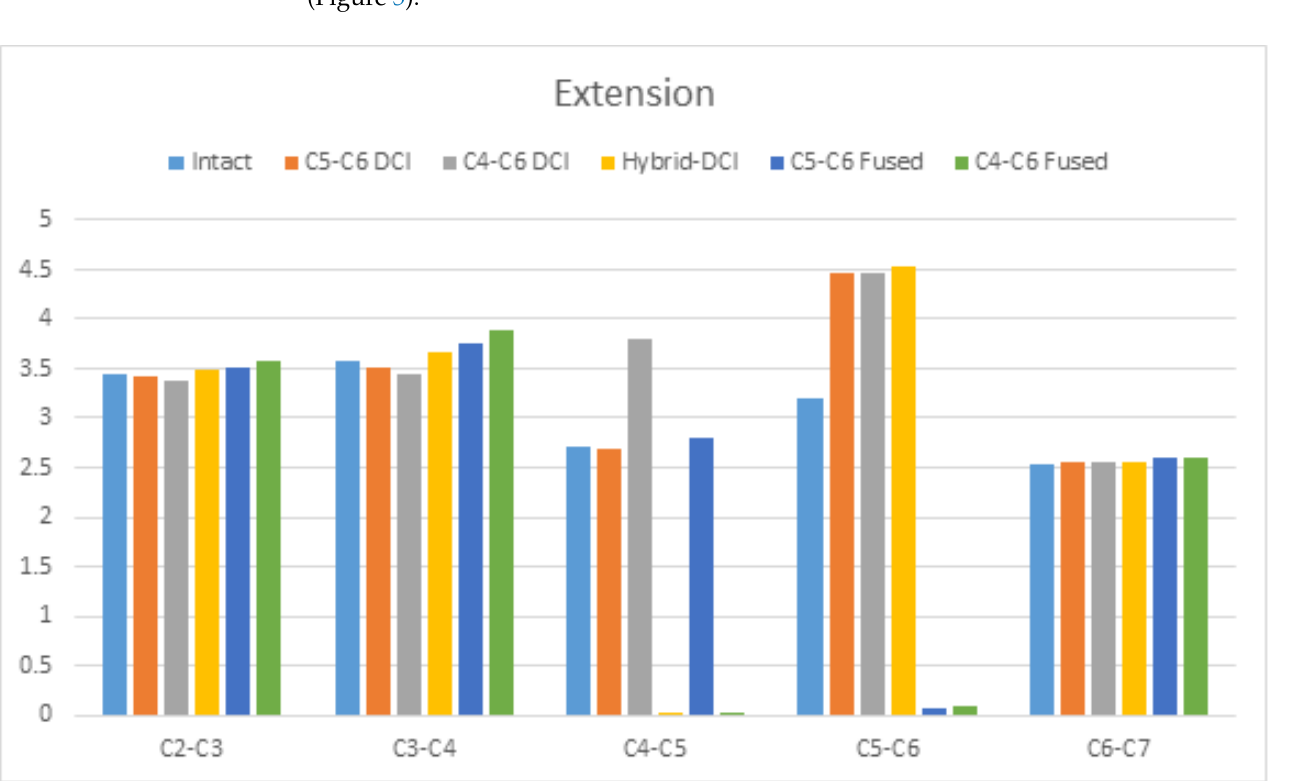
Figure 6. The comparison of ROMs during lateral bending among the C5–C6 DCI, C4–C6 DCI, hybrid DCI, C5–C6 ‐ fused, and C4–C6 ‐ fused models. The vertical axis shows ROMs in degrees.